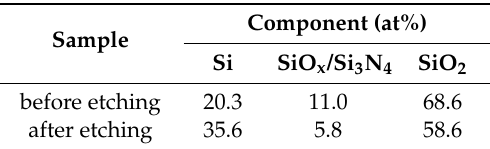
Table 4. Relative abundance (at%) and possible assignments of the components found in XPS Si 2p detail spectra of Si/MC powder samples before and after HF etching.